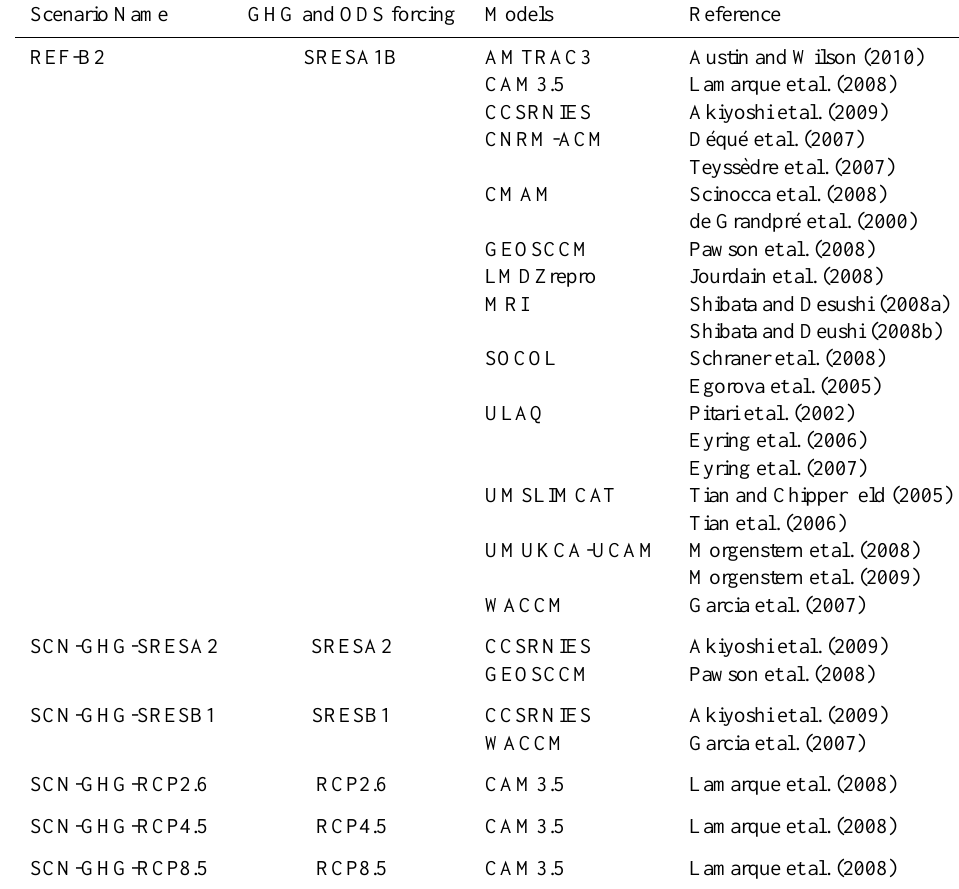
Table 1. Simulations used in the